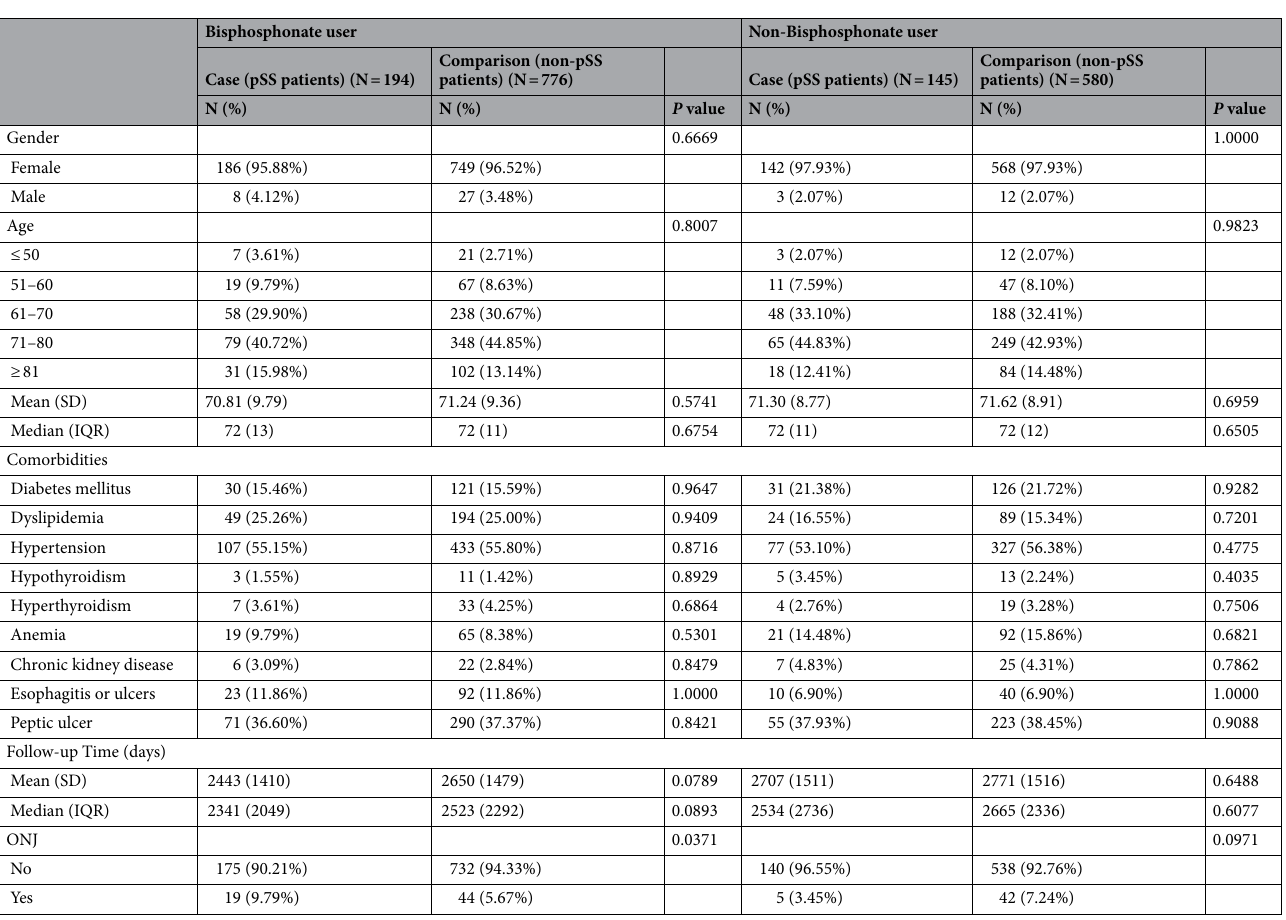
Table 1. Baseline characteristics of bisphosphonate and non-bisphosphonate users in pSS or non-pSS patients. pSS primary Sjogren syndrome, ONJ osteonecrosis of the jaw.